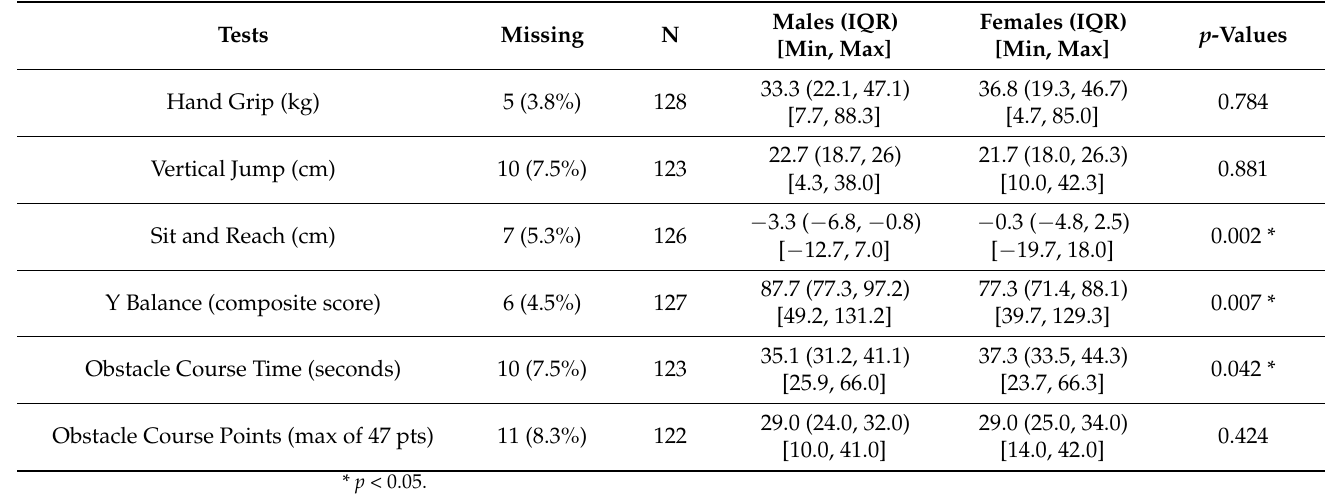
Table 3. Comparisons of Physical Assessment between Males and Females.